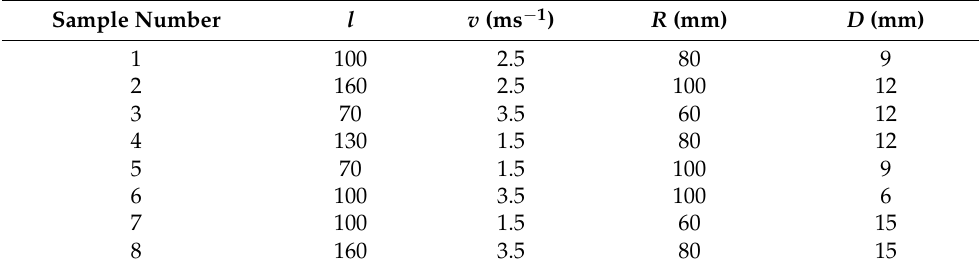
Table 4. The structural and experimental parameters of the flow channel